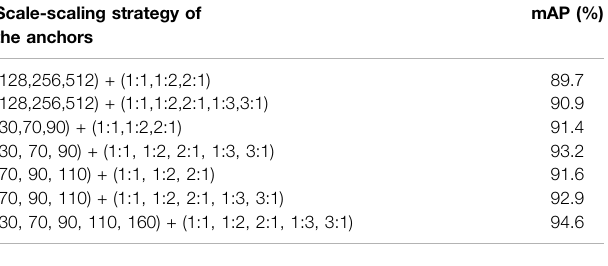
TABLE 4 | Anchors size validation for logical element recognition. Scale-scaling strategy of the anchors